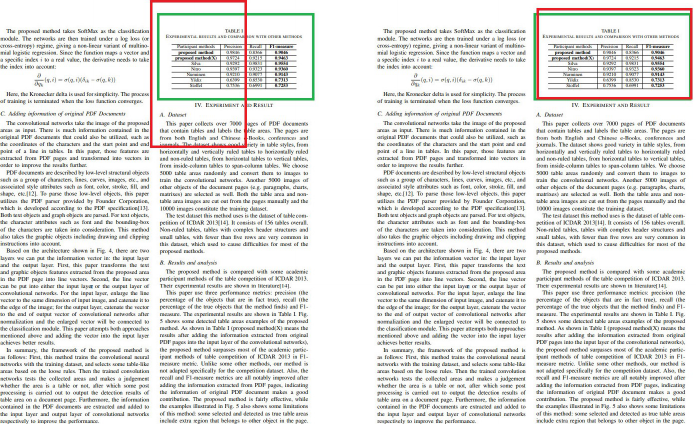
Figure 12. An instance of a precise and imprecise table detection. Green color represents the ground- truth tabular area whereas red color denotes the predicted tabular